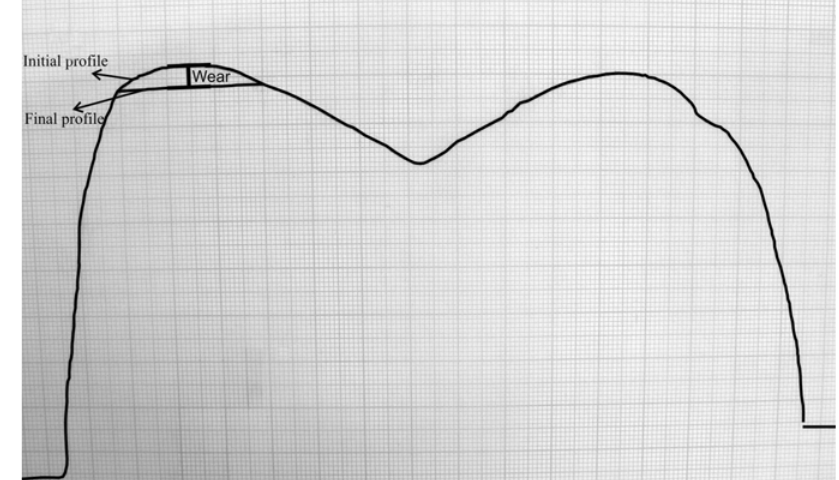
FIGURE 3- Measure of abrasion wear determined by the linear difference between the initial and final profiles